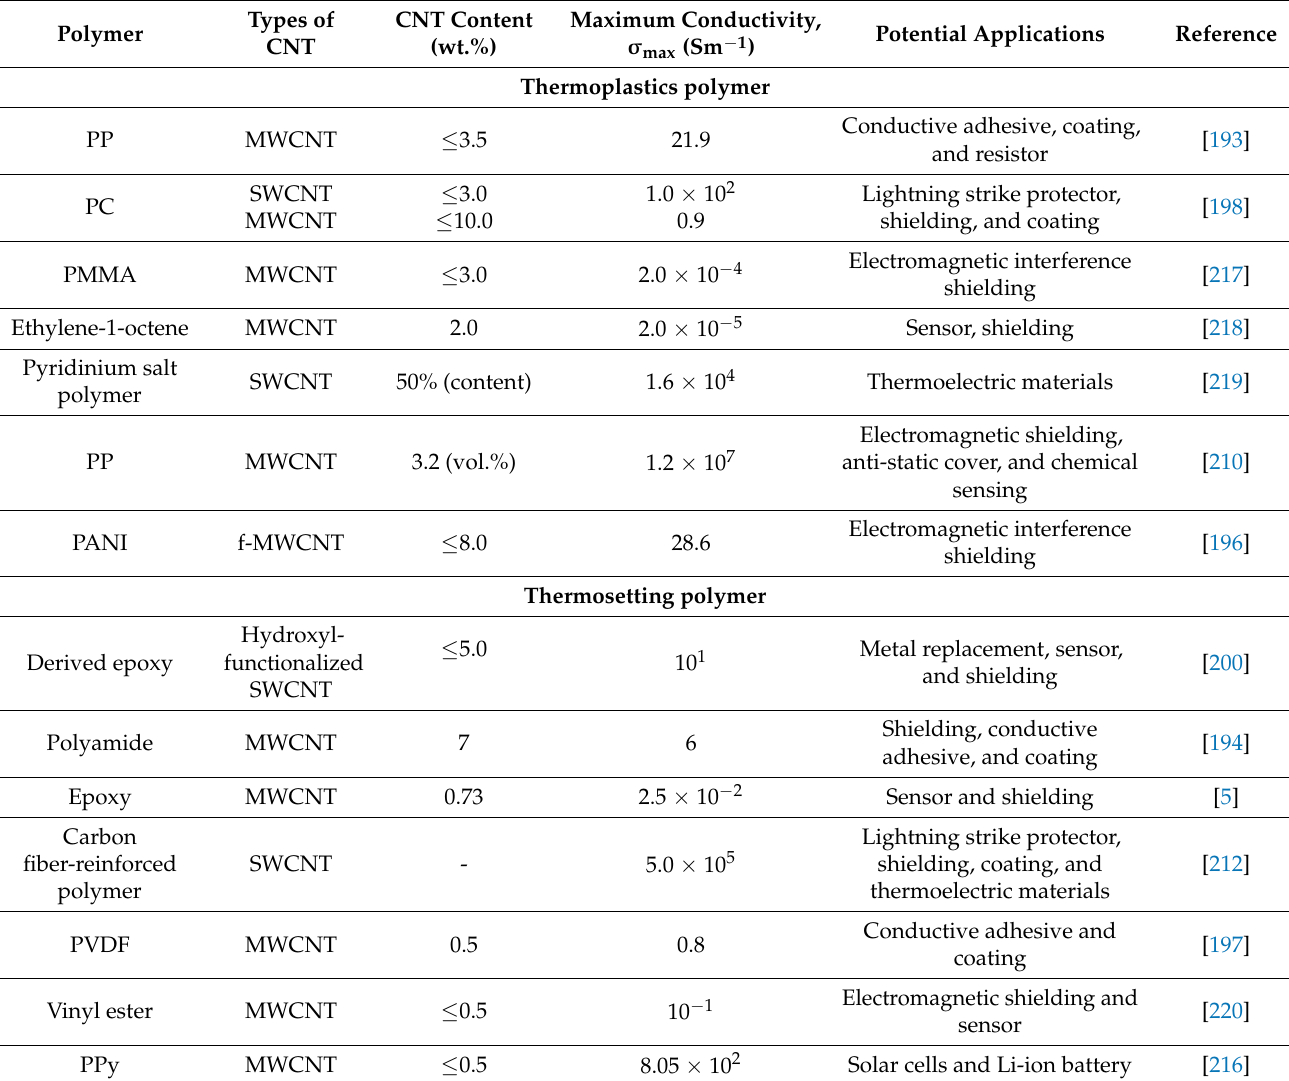
Table 9. Electrical conductance of CNTs and polymers with potential